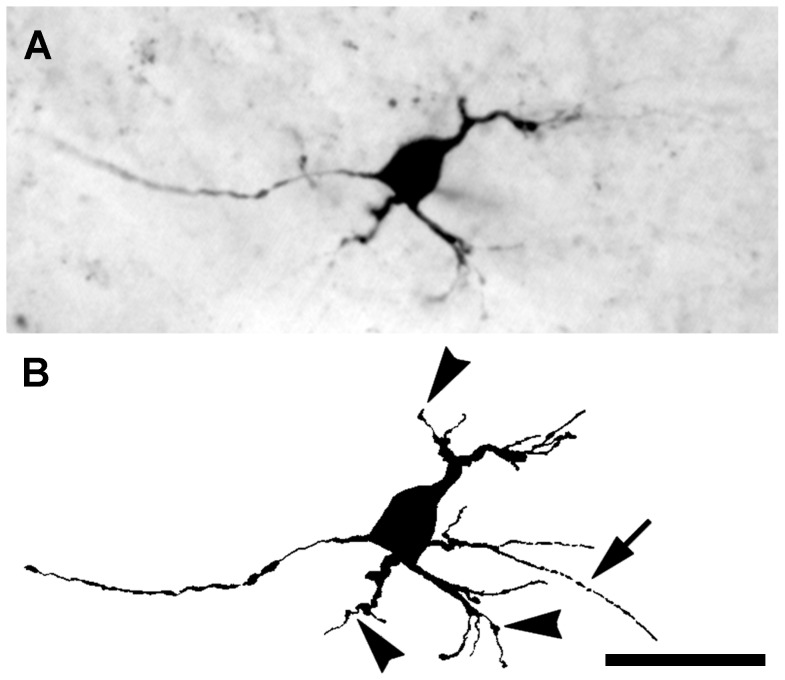
Response to axotomy from a lesion of the visual cortex at 72 hours.(A) A micrograph of a BDA-labeled dLGN projection neuron with swollen primary dendrites and only a few short remnants of secondary dendrites remaining. (B) A camera lucida drawing of the neuron shown in A. The arrow indicates a discontinuous distal segment of a dendrite. Arrowheads indicate bulb-like protrusions on dendrites. Scale bar: 50 µm.